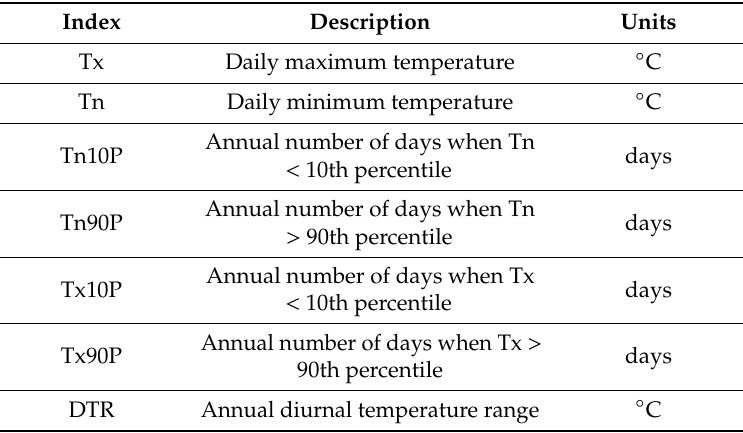
Table 2. List of relevant ETCCDMI indices utilized in this study.